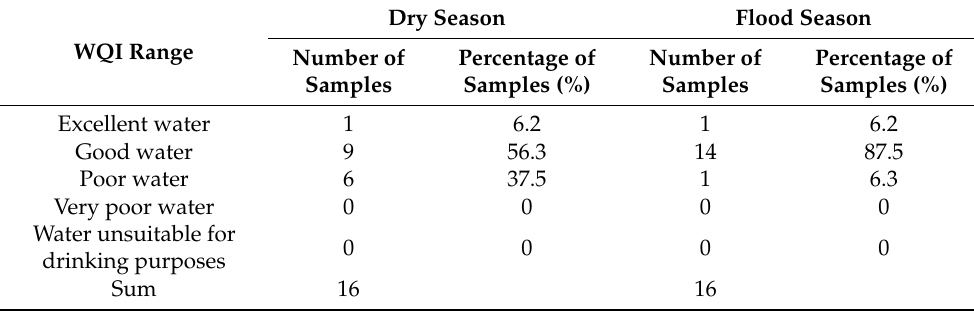
Table 3. Water quality classification of different seasons along the Ye